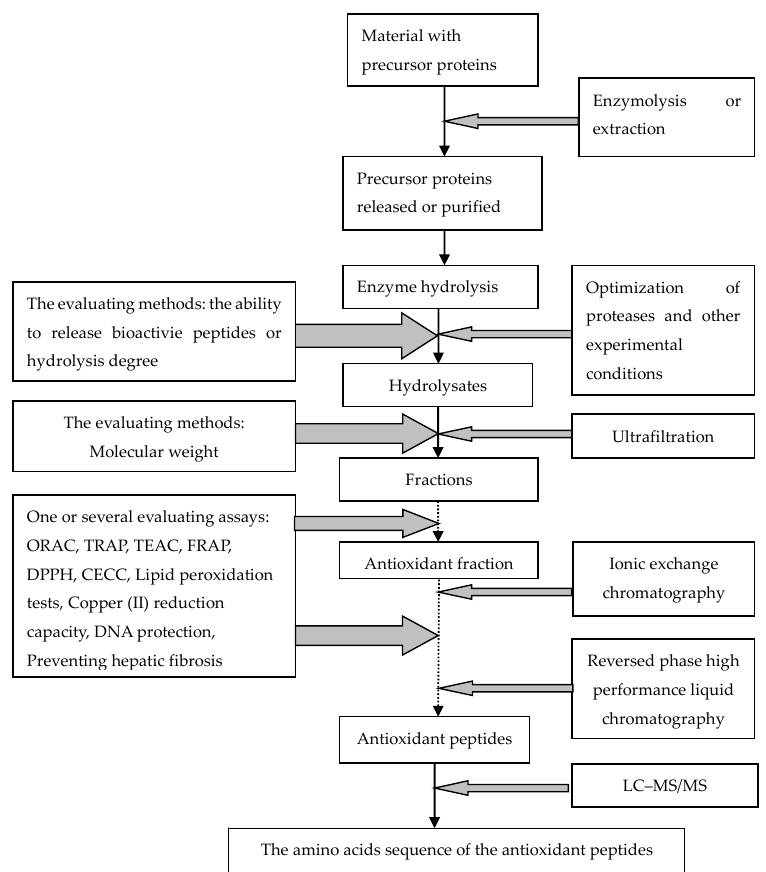
Figure 1. Preparation and identification of the novel antioxidant peptides from natural proteins. Note: the dotted line means that the process doesn’t always happen. The abbreviated indexes are: ORAC—Oxygen Radical Absorbance Capacity assay; TRAP—Total Radical trapping Antioxidant Parameter; TEAC—Trolox Equivalent Antioxidant Capacity; FRAP—Ferric ion-Reducing Antioxidant Power; DPPH—DiPhenyl-1–PicrylHydrazyl; CECC—Carnosine Equivalent iron Chelation Capacity; LC-MS/MS—liquid chromatography mass chromatography/mass